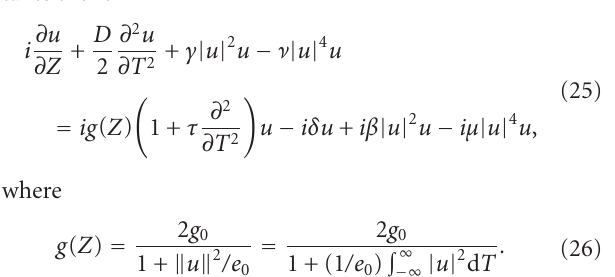
Figure 4: Projection of the N = 2 evolution to POD modes. The top two figures are the singular values σ j of the evolution demonstrated in (2) on both a regular scale and a log scale. This demonstrates that the N = 2 soliton dynamics is primarily a two-mode dynamics as these two modes contain approximately 95% of the evolution energy. The first three modes are shown in the bottom panel. (saturable absorber) of the cavity. In particular, the equation takes the